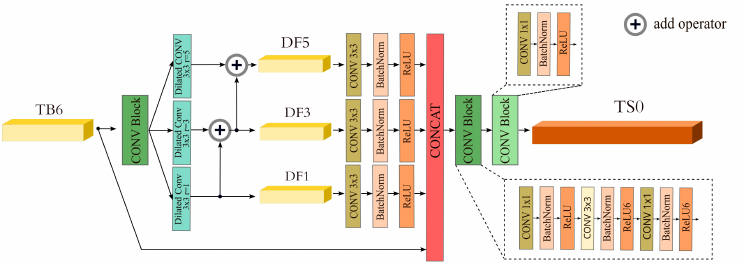
Figure 6. The archiecture of